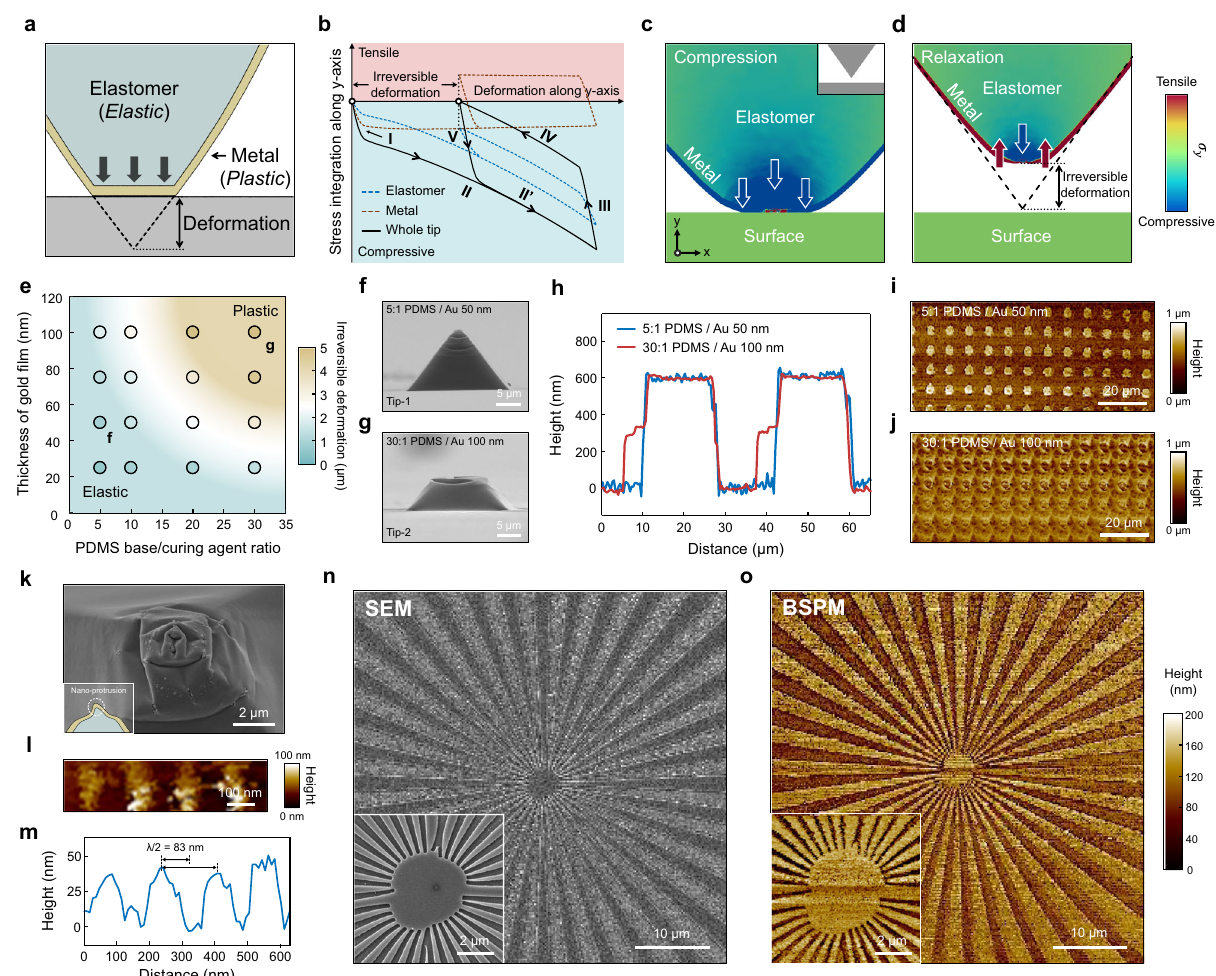
Fig. 3 Lateral resolution of BSPM. a Schematic illustration depicting the deformation of the metal-coated elastomer tip. b Simulated result of the overall stress in the metal-coated elastomeric composite during the compressive-relaxation cycle. Simulated stress distribution in the metal-coated elastomeric composite in the compression ( c ) and relaxation ( d ) steps. The inset in c shows the geometry of a metal-coated elastomeric composite at the initial state. e Magnitude of the irreversible deformation of the tip depending on the base/curing agent ratio of the PDMS and the thickness of the gold fi lm. SEM images of the metal-coated elastomer tip after the compression-relaxation test under 5:1 PDMS/Au 50 nm (Tip-1, f ) and 30:1 PDMS/Au 100 nm (Tip-2, g ). h , Line pro fi les of the 16 × 16- μ m 2 square patterns with a thickness of 600 nm measured by the two tips under different deformation conditions. Topography images of the 4- μ m-diameter circle patterns with a thickness of 400 nm measured by tip-1 ( i ) and tip-2 ( j ). k SEM image of the wrinkled structure on the tip. Topography ( l ) and line pro fi le ( m ) of the features with a width of 83 nm and a thickness of 40 nm. SEM ( n ) and BSPM ( o ) images of the Siemens star test chart with a thickness of 32 nm. The insets show enlarged views of the